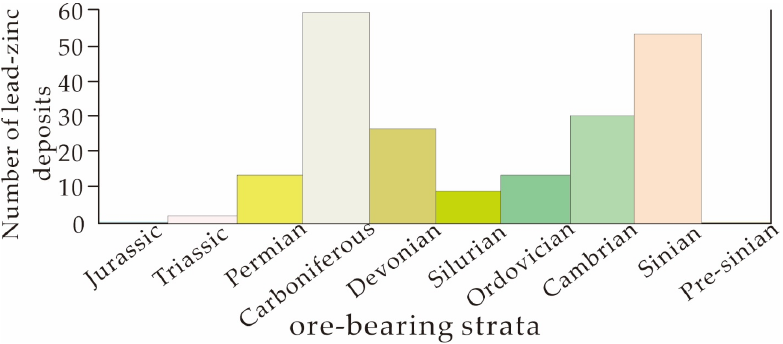
Figure 2. Statistics of the wall rocks strata of the MVT lead–zinc deposit in Sichuan, Yunnan and Guizhou (modified from [31]).